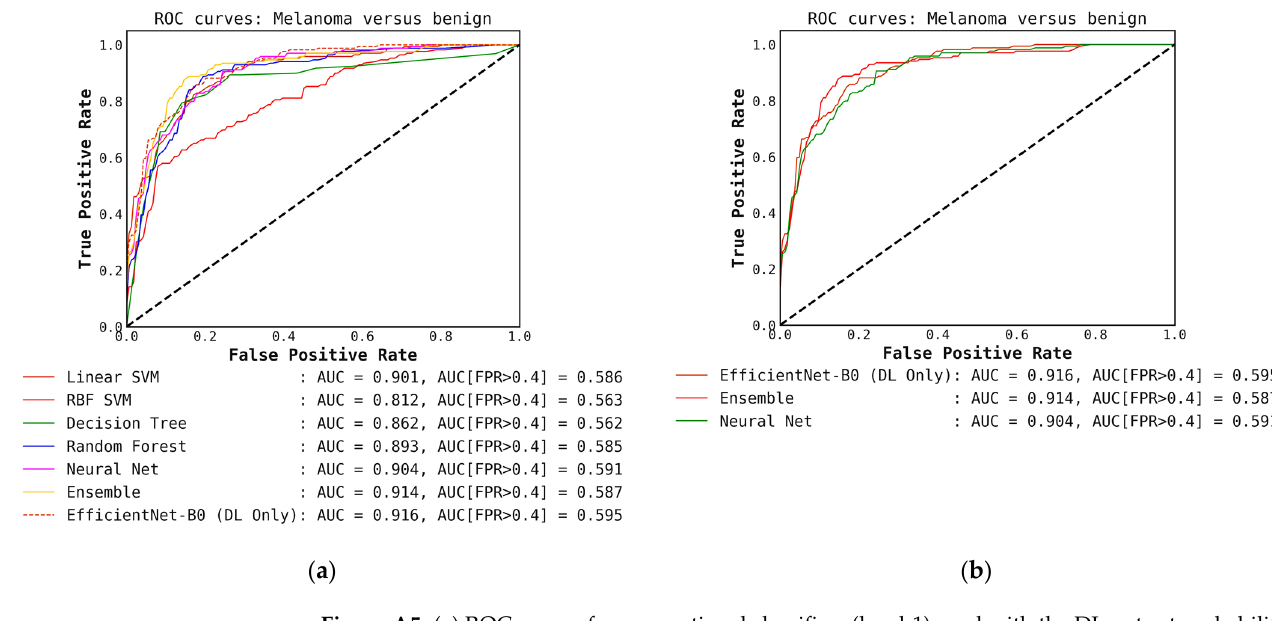
Figure A5. ( a ) ROC curves for conventional classifiers (level-1) used with the DL output probabilities from the EfficientNet-B0 (level-0) model and the hand-crafted features (cascade generalization). ( b ) Figure showing ROC curves only for the EfficientNet-B0 (level-0) model, the ensemble of conventional classifiers, and the best conventional level-1 classifier using the EfficientNet-B0 probability outputs. The AUC and the AUC for FPR higher than 0.4 are both presented for comparison. All values are rounded to three significant digits.